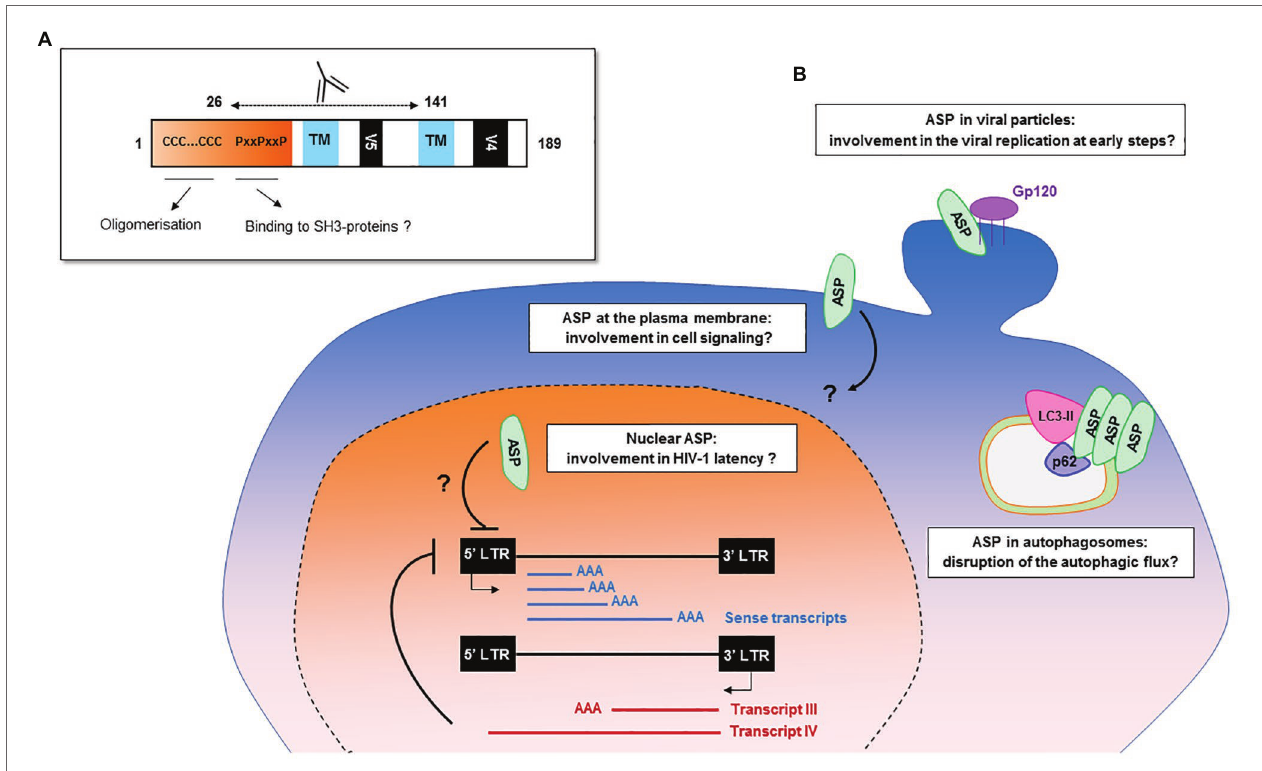
FIGURE 6 | Potential functions of HIV-1 antisense transcripts and ASP in infected cells. (A) Potential functions of ASP motifs and localization of its epitope in vivo . Patients’ antibodies target the 26–141 core region of ASP encompassing the V5 and proline-rich motifs. (B) Schematic representation of the potential functions of ASP and of antisense transcripts in infected cells. In addition to their messenger function, the antisense transcripts of HIV-1 may contribute to the establishment and maintenance of viral latency by recruiting chromatin-modifying enzymes to the 5 ′ LTR of the proviral genome. ASP oligomers, by interacting with LC3-IIb and p62 in autophagosomes, are degraded by a selective autophagy process and disrupt the autophagic flux of infected cells. At the plasma membrane, ASP could be involved in deregulating infected cells by disrupting cell signaling pathways or the expression of immune receptors. In the nucleus, ASP may be involved in the establishment and maintenance of viral latency, as was described for HBZ. As ASP was detected at the surface of viral particles, it may also play a role in the very early stages of the viral cycle, such as viral